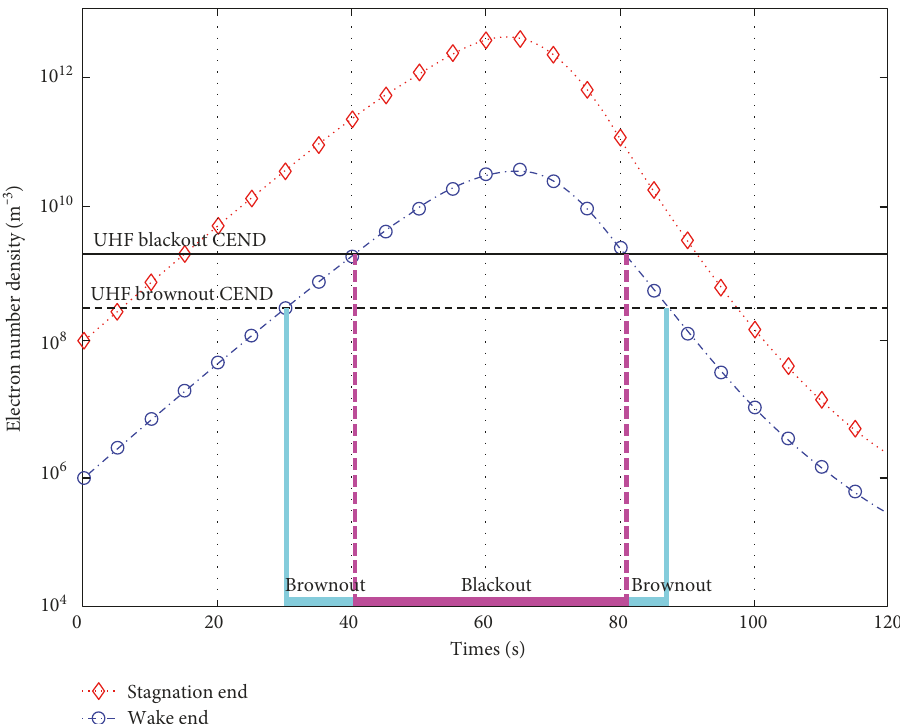
Figure 6: Predicted electron number density pro fi les (brownout: blue 30s ~ 41s, 81s ~ 87s; red 6 s ~ 15 s, 91 s ~ 98 s; blackout: blue 41 s ~ 81 s; red 15s ~